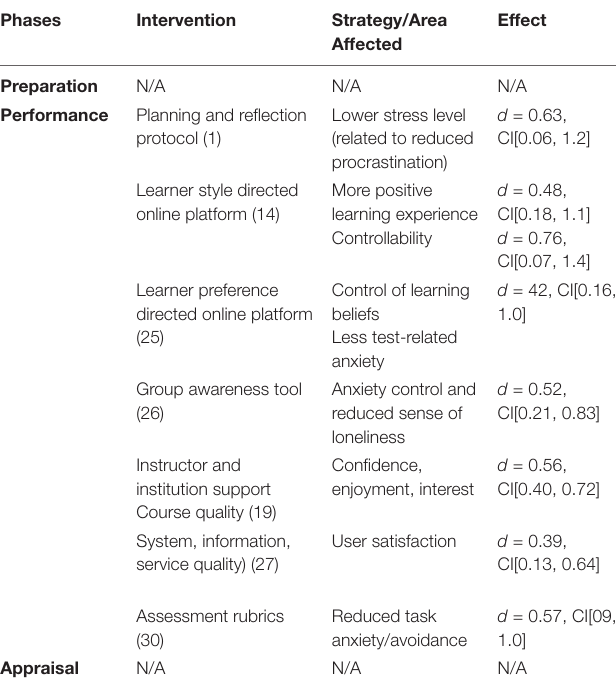
TABLE 6 | Emotion regulation support interventions and areas